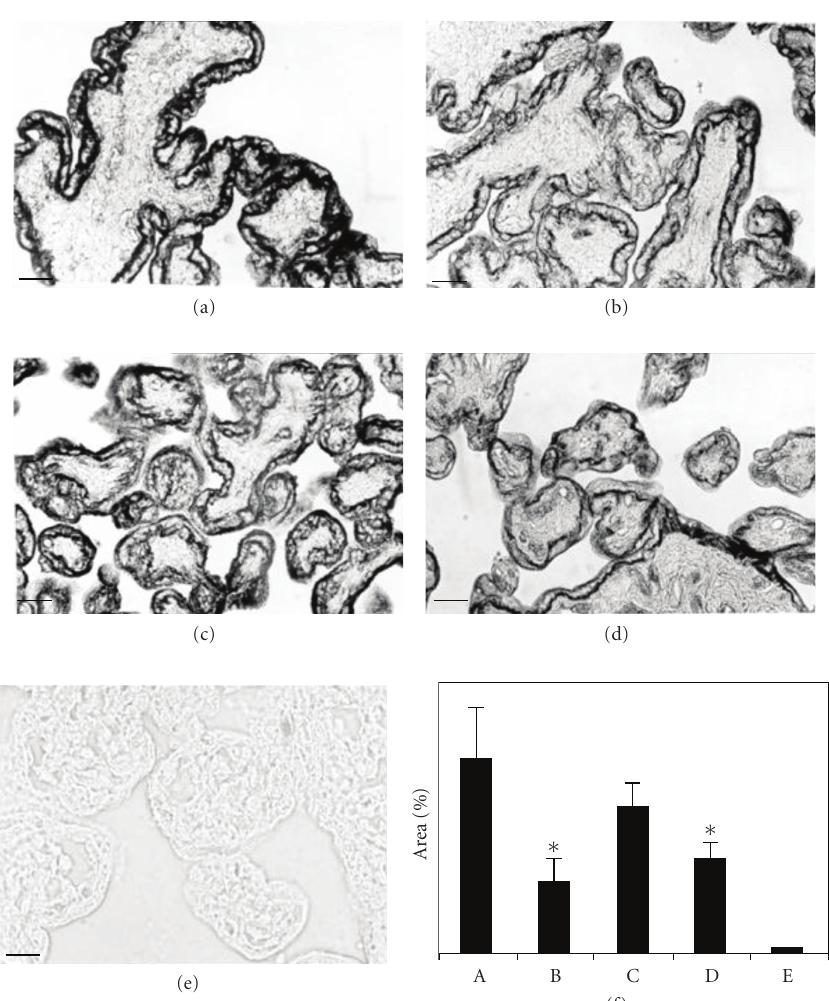
Figure 3: GLUT1 immunodetection in para ffi n-embedded placental villi sections cultured for 48 hours. (a) Uninfected control placental villi (GLUT1 expression was intensively marked on the apical and basal syncytiotrophoblast cell membrane); (b) normal placental villi in vitro infected with T. cruzi ; (c) normal placental villi cultured under high glucose concentration media; (d) normal placental villi cultured under high glucose concentration media and in vitro infected with T. cruzi ; (e) negative control placental villi (without GLUT1 antiserum incubation); (f) image quantification made by “Image Tool” UTHSCSA version 3.00, which indicates the percentage of the marked area; values shown are the mean ± SE of seven samples from representative experiments (A: control placental villi, without infection; B: infected normal placental villi; C: normal placental villi cultured under high glucose media; D: infected normal placental villi cultured under high glucose concentration media; E: negative control placental villi). Original magnification: 400x. The scale bar represents 1 µ m. ∗ Significantly di ff erent from the control placental villi ( P < 0 . 05; n = 7; paired t